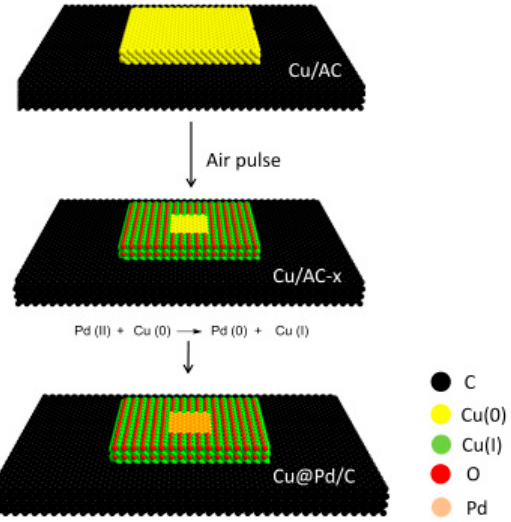
Figure 1. Procedure for the preparation of Cu@Pd/C.